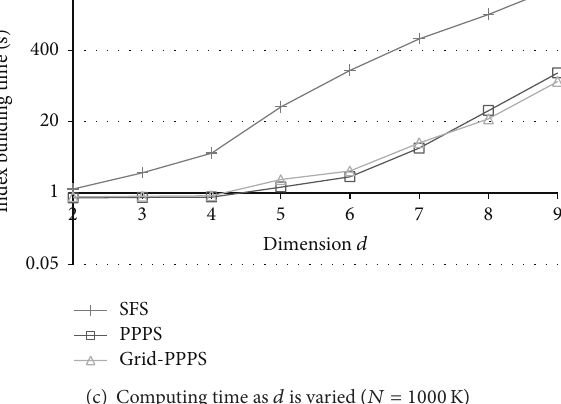
the indexing building time of ABSP [7]. However, PPPS